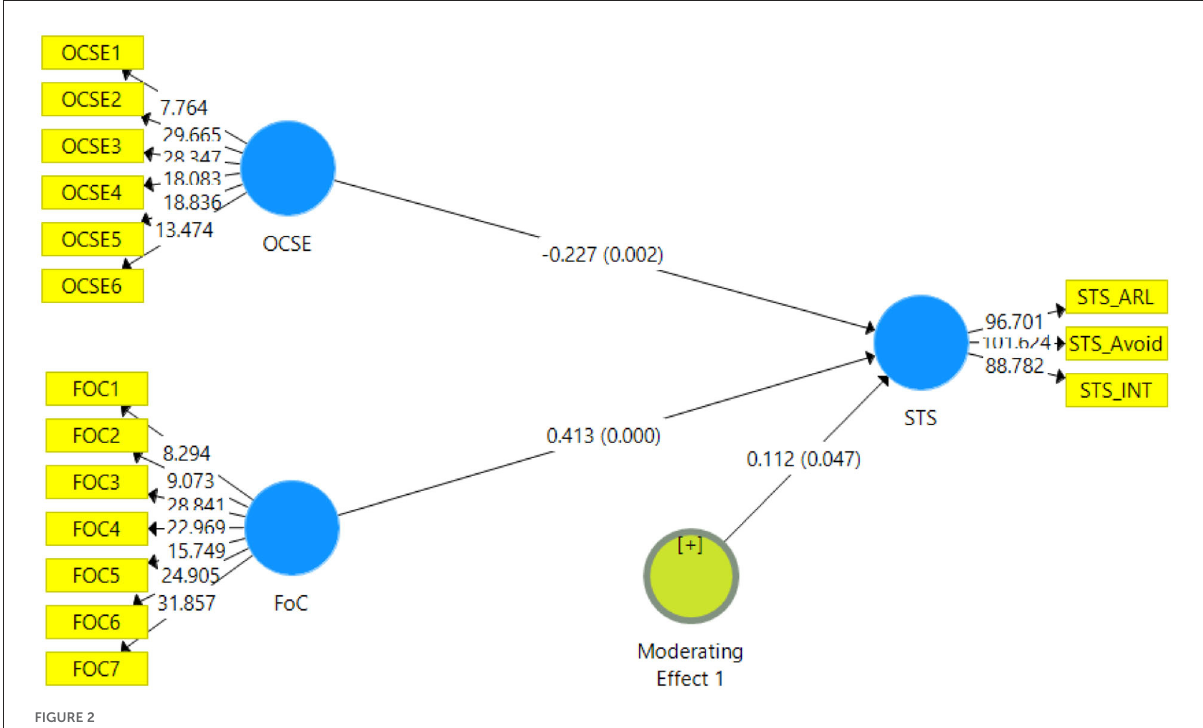
FIGURE2 Estimated